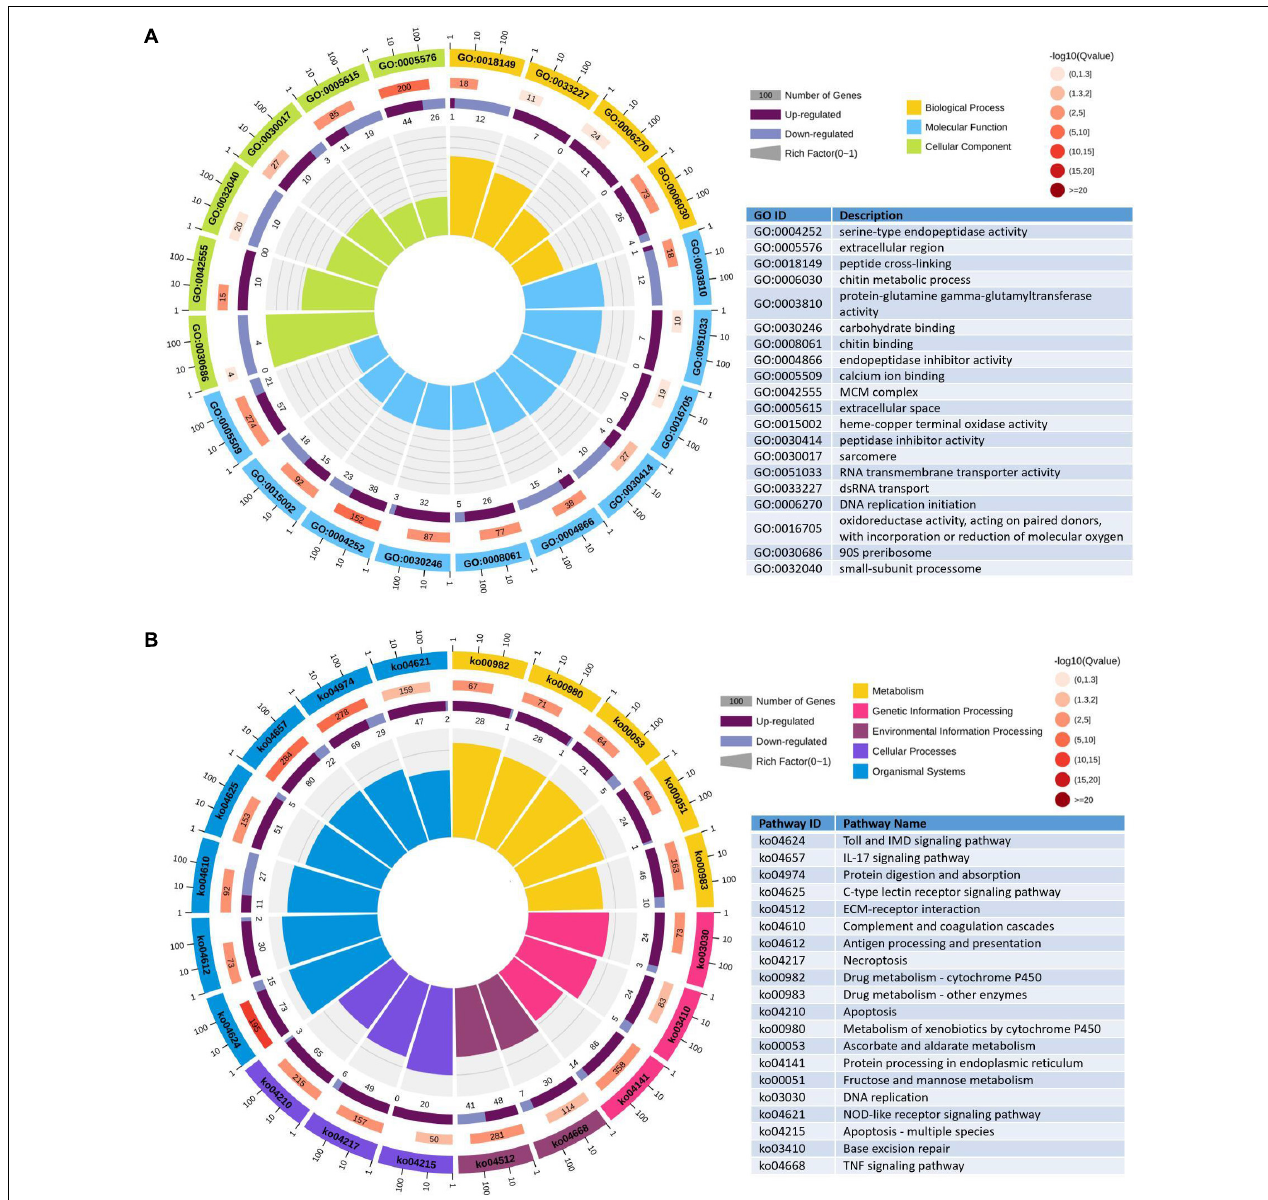
FIGURE 8 | Gene Ontology (GO) terms and Kyoto Encyclopedia of Genes and Genomes (KEGG) pathway enrichment analysis of differentially expressed genes (DEGs). (A) The first lap indicates the top 20 GO terms and the number of genes that correspond to the outer lap. The second lap indicates the number of genes in the genome background and the q -values for enrichment of the DEGs for the specified biological process. The third lap indicates the ratio of upregulated genes (deep purple) and downregulated genes (light purple). The fourth lap indicates the enrichment factor of each GO term. (B) The first lap indicates the top 20 KEGG terms and the number of genes that correspond to the outer lap. The second lap indicates the number of genes in the genome background and q -values for enrichment of the DEGs for the specified biological process. The third lap indicates the ratio of upregulated genes (deep purple) and downregulated genes (light purple). The fourth lap indicates the enrichment factor of each KEGG